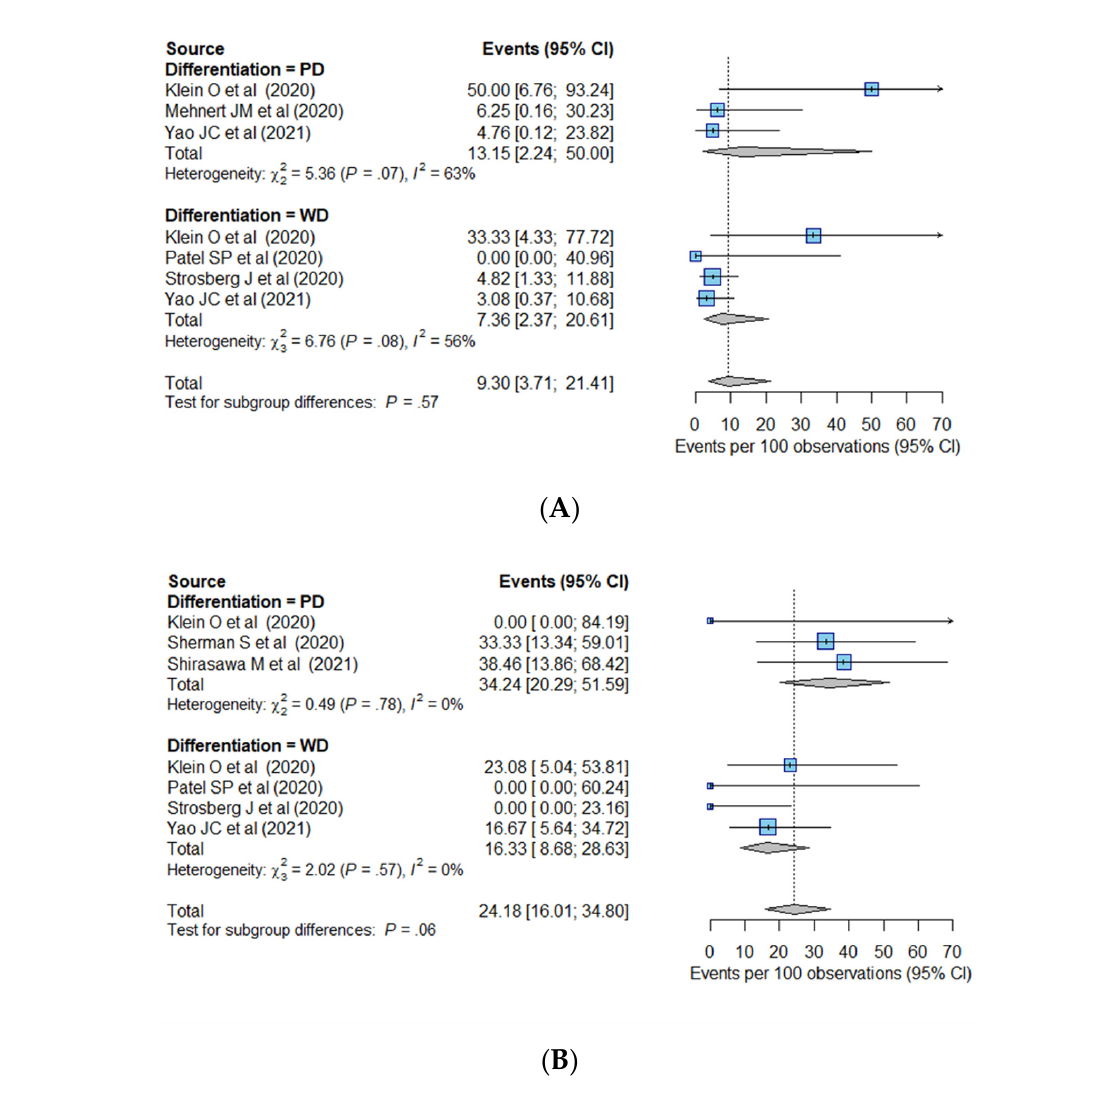
Figure 3. Sensitivity analysis of overall response rate according to tumor differentiation in the ( A ) GEP and ( B ) thoracic groups. CI, confidence interval; GEP, gastro–entero–pancreatic; PD, poorly differentiated; WD, well-differentiated.